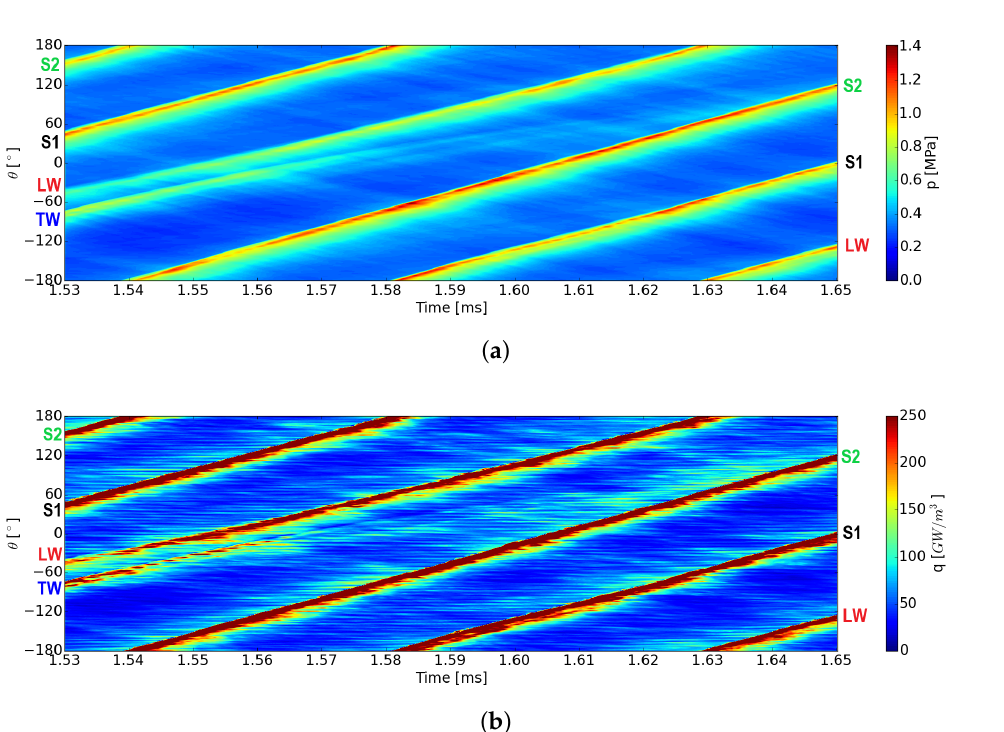
Figure 9. High time resolution simulation data of detonation surfaces during DMT focusing on the trailing wave failure time frame of interest from 1.530 ms to 1.650 ms showing pressure ( a ) and heat release ( b